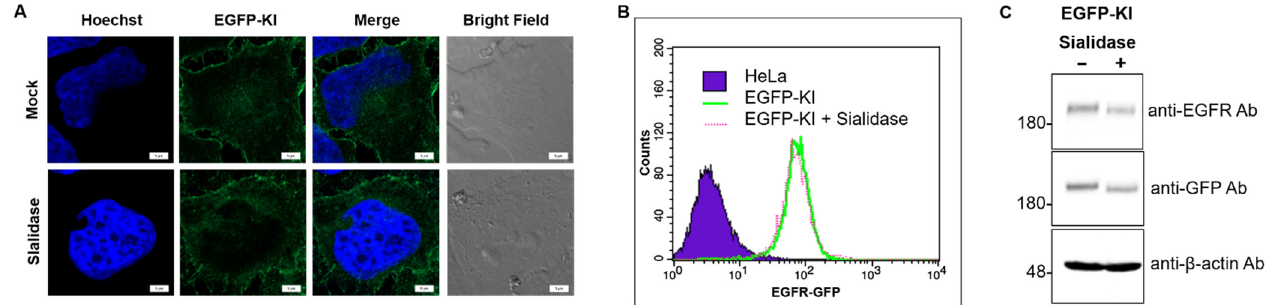
Figure 3. Effects of sialidase on EGFR-GFP in EGFP-KI cells. ( A ) Confocal fluorescence images of EGFP-KI cells with and without prior treatment with sialidase (3 U/mL) for 1 h at 37 °C. Sialidase did not affect the distribution or fluorescent signal of EGFR-GFP. Scale bar, 5 µm; ( B ) Flow cytometry analysis of EGFP-KI cells with and without prior sialidase treatment; ( C ) Western blot analysis of EGFR-GFP levels in EGFP-KI cells with and without prior sialidase treatment.